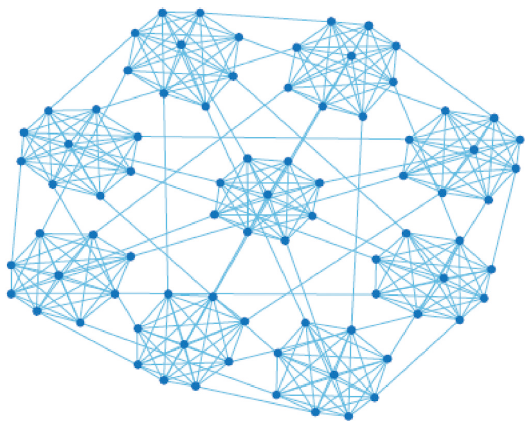
Figure 2: The graph NT